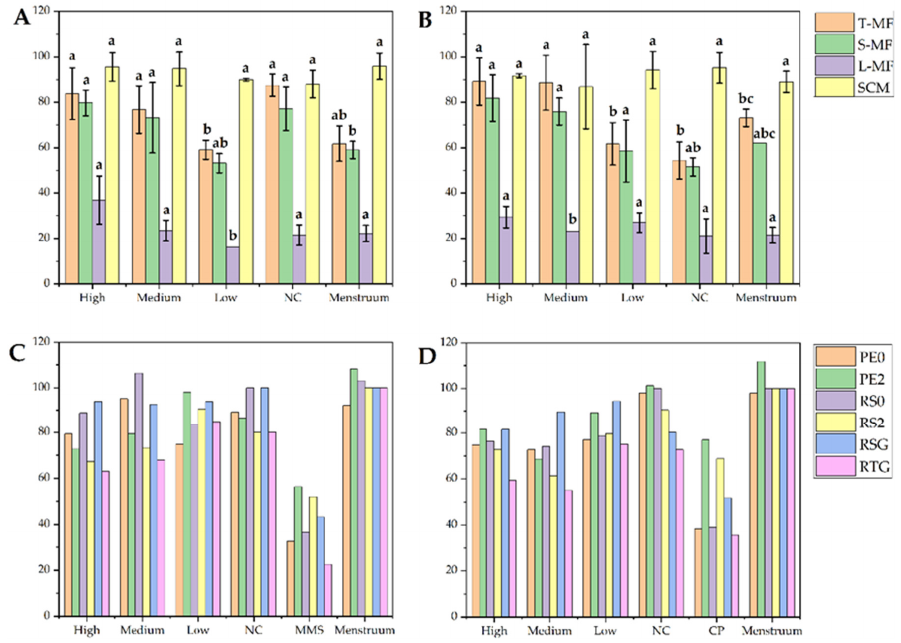
Figure 4. L5178Y cell TK gene mutation frequency and cell toxicity of in vitro mammalian cell TK gene mutation test of CCSKO. ( A ) L5178Y cell TK gene mutation frequency in the absence of S9 ( −